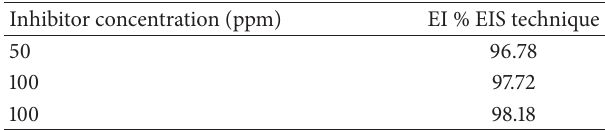
Table 2: Inhibition efficiency values for carbon steel in 1MHCl with different concentrations of AMPS calculated by EIS